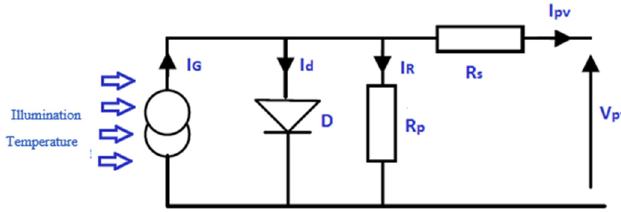
Table 1. PV panel